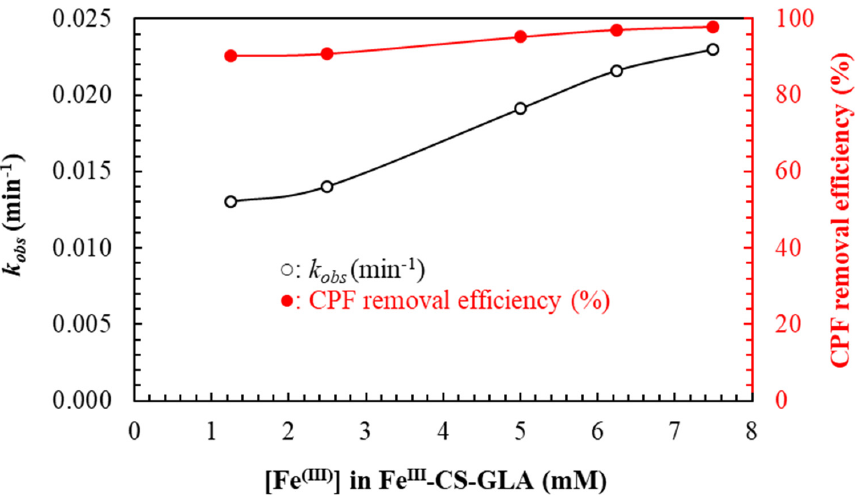
Figure 9. The effects of [Fe ӀӀӀ ] content in Fe III -CS-GLA on k obs (min − 1 ) and CPF removal efficiency